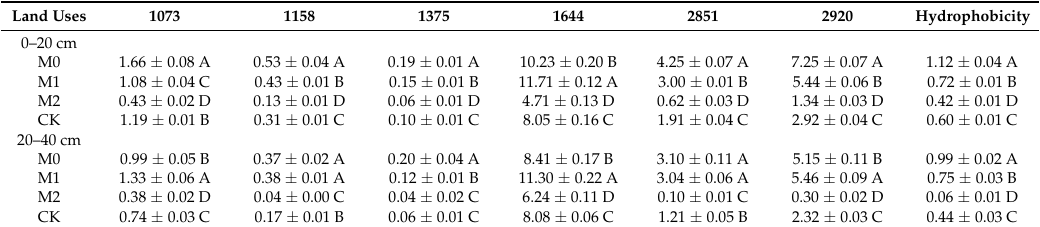
Figure 2. FTIR (fourier transform infrared spectra) of bulk soil organic carbon (SOC) in topsoil ( a ) and subsoil ( b ) soil layer under different management strategies. Spectra were stacked to facilitate visualization of the differences between different management strategies. Table 2. The intensity (area) of each peak determined by FTIR spectroscopy in SOM (mean ± SD, n =